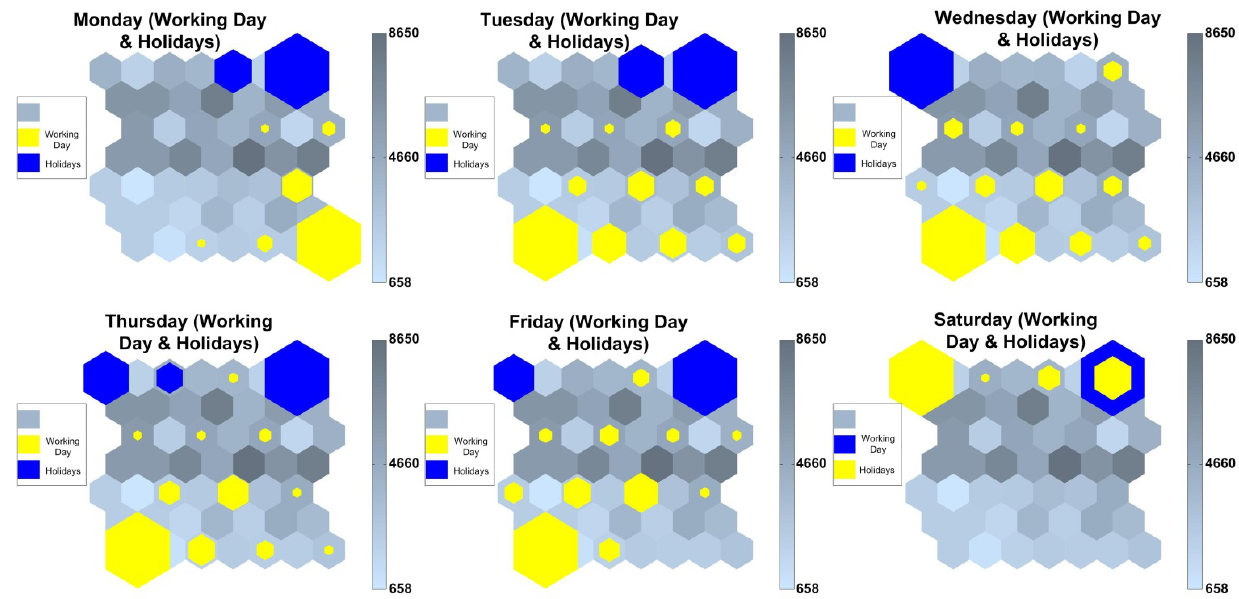
Figure 7. Activation map for workability and